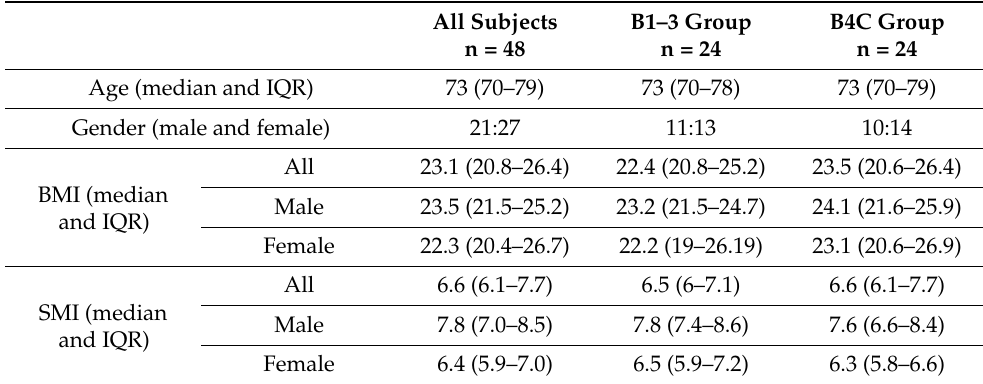
Table 1. Summary of subjects’ profiles; IQR: interquartile range; BMI: body mass index; SMI: skeletal muscle mass index. Statistical analyses: B1–3 group vs. B4C group ( p > 0.05, Mann–Whitney U test in all items).